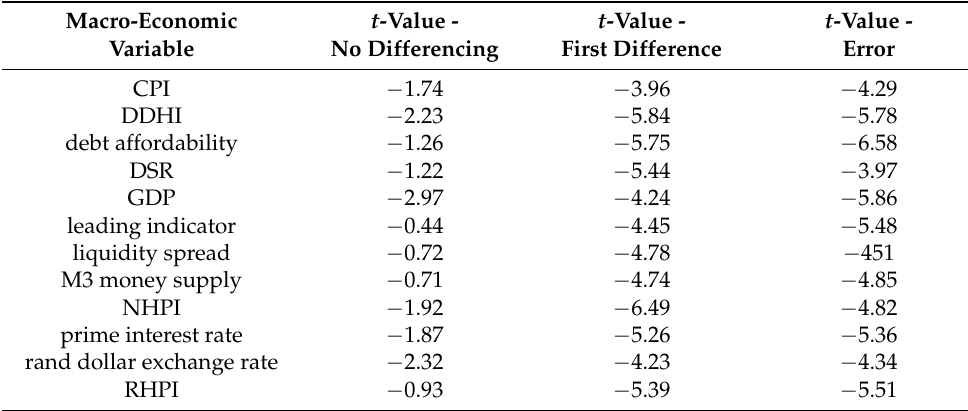
Table 1. Test statistic values for the Augmented Dicky-Fuller